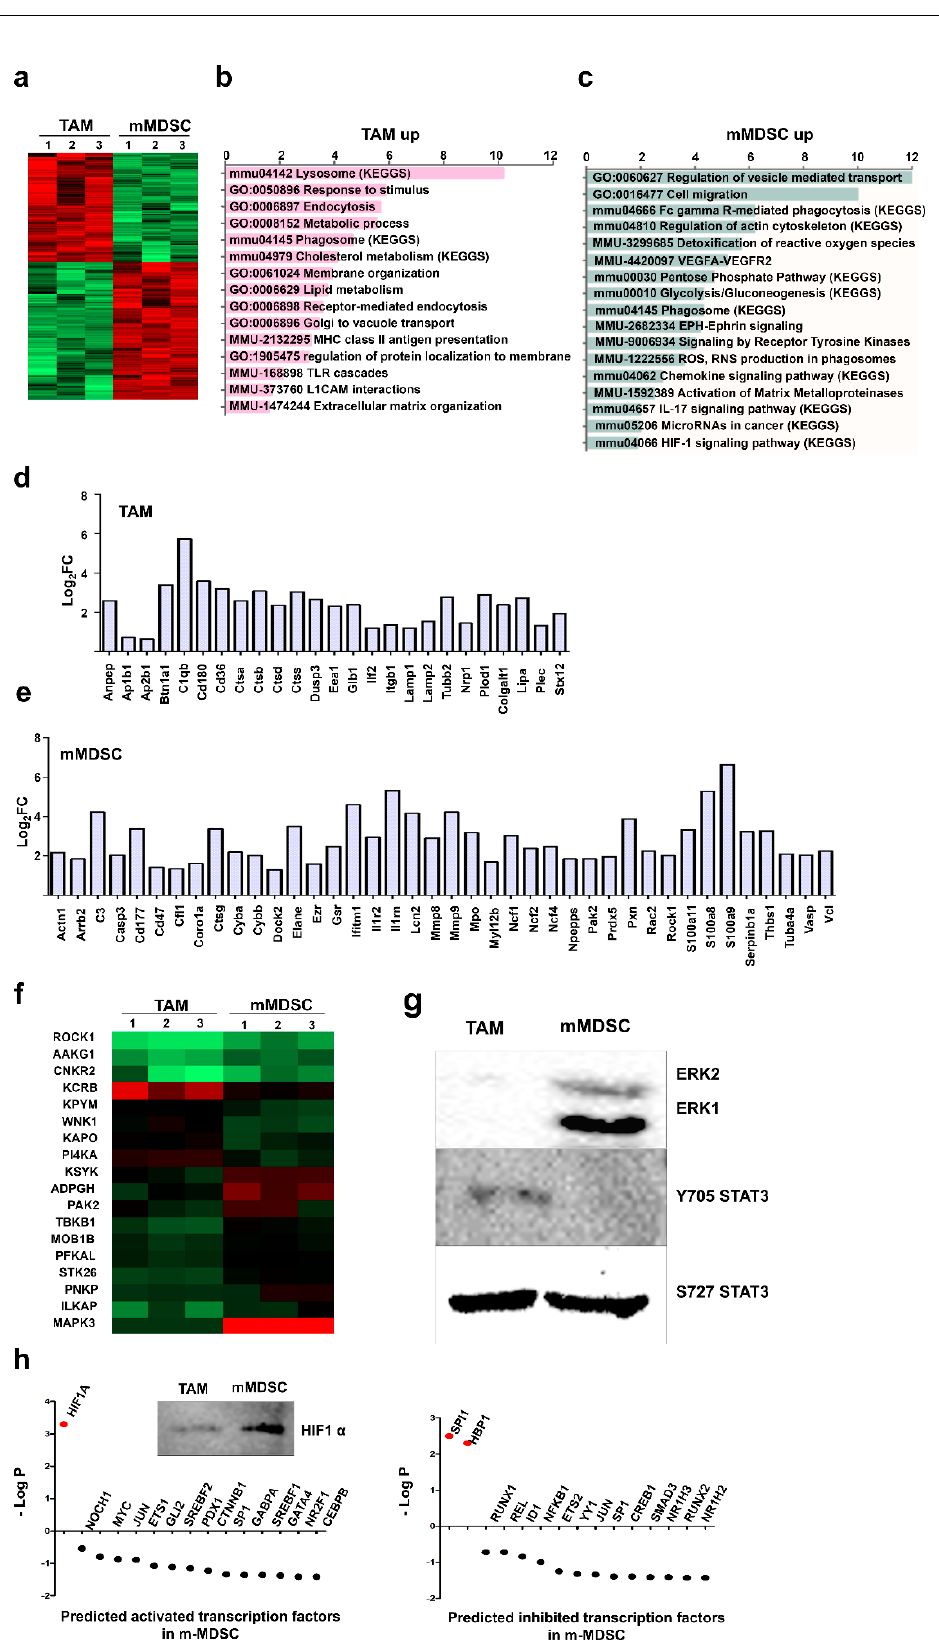
Figure 5. Differential proteomes between TAM and monocytic MDSCs discriminate both populations. ( a ) Heat map of the differentially expressed proteins ( P < 0.01) between the indicated samples with 3 independent biological triplicates of TAM and m-MDSC cultures. Red and green, up and down-regulated proteins, respectively. ( b ) The bar graphs represent the enrichment of the differentially pathways in the TAM proteome, as analyzed by gene ontology and KEGGs pathways. ( c )